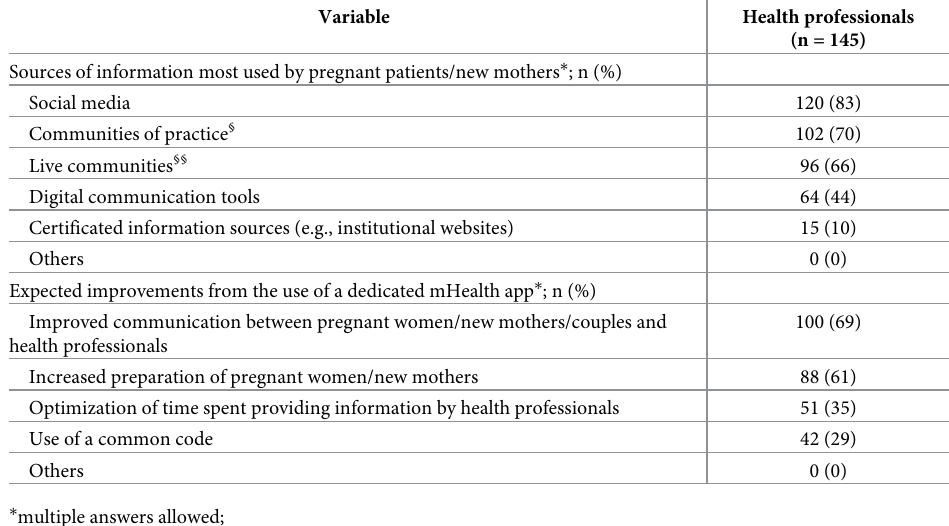
Table 2. Summary of secondary users’ responses on the sources of information most frequently used by their patients and the improvements expected from using an mHealth app to support the first 1000 days of